Question: What visual encoding does this figure use to show its data?
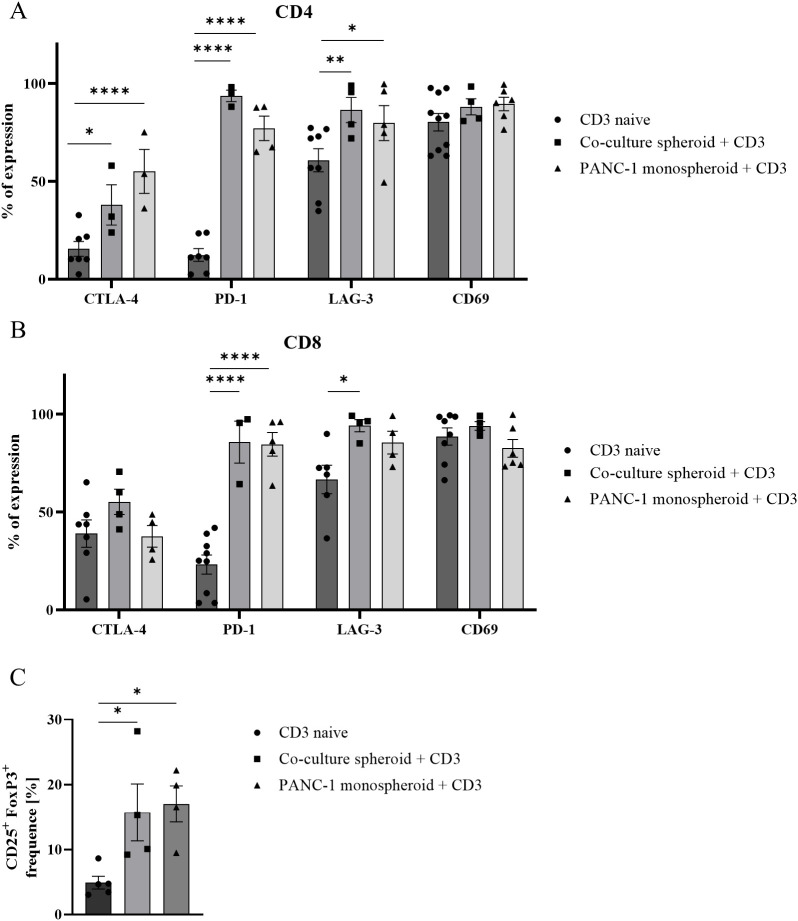
Answer: bar